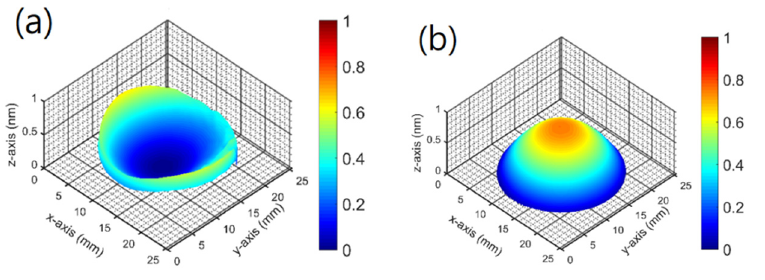
Figure 4. Three-dimensional (3D) surface contour of the B270 glass substrate ( a ) before coating; ( b ) after coating. ( b ) after